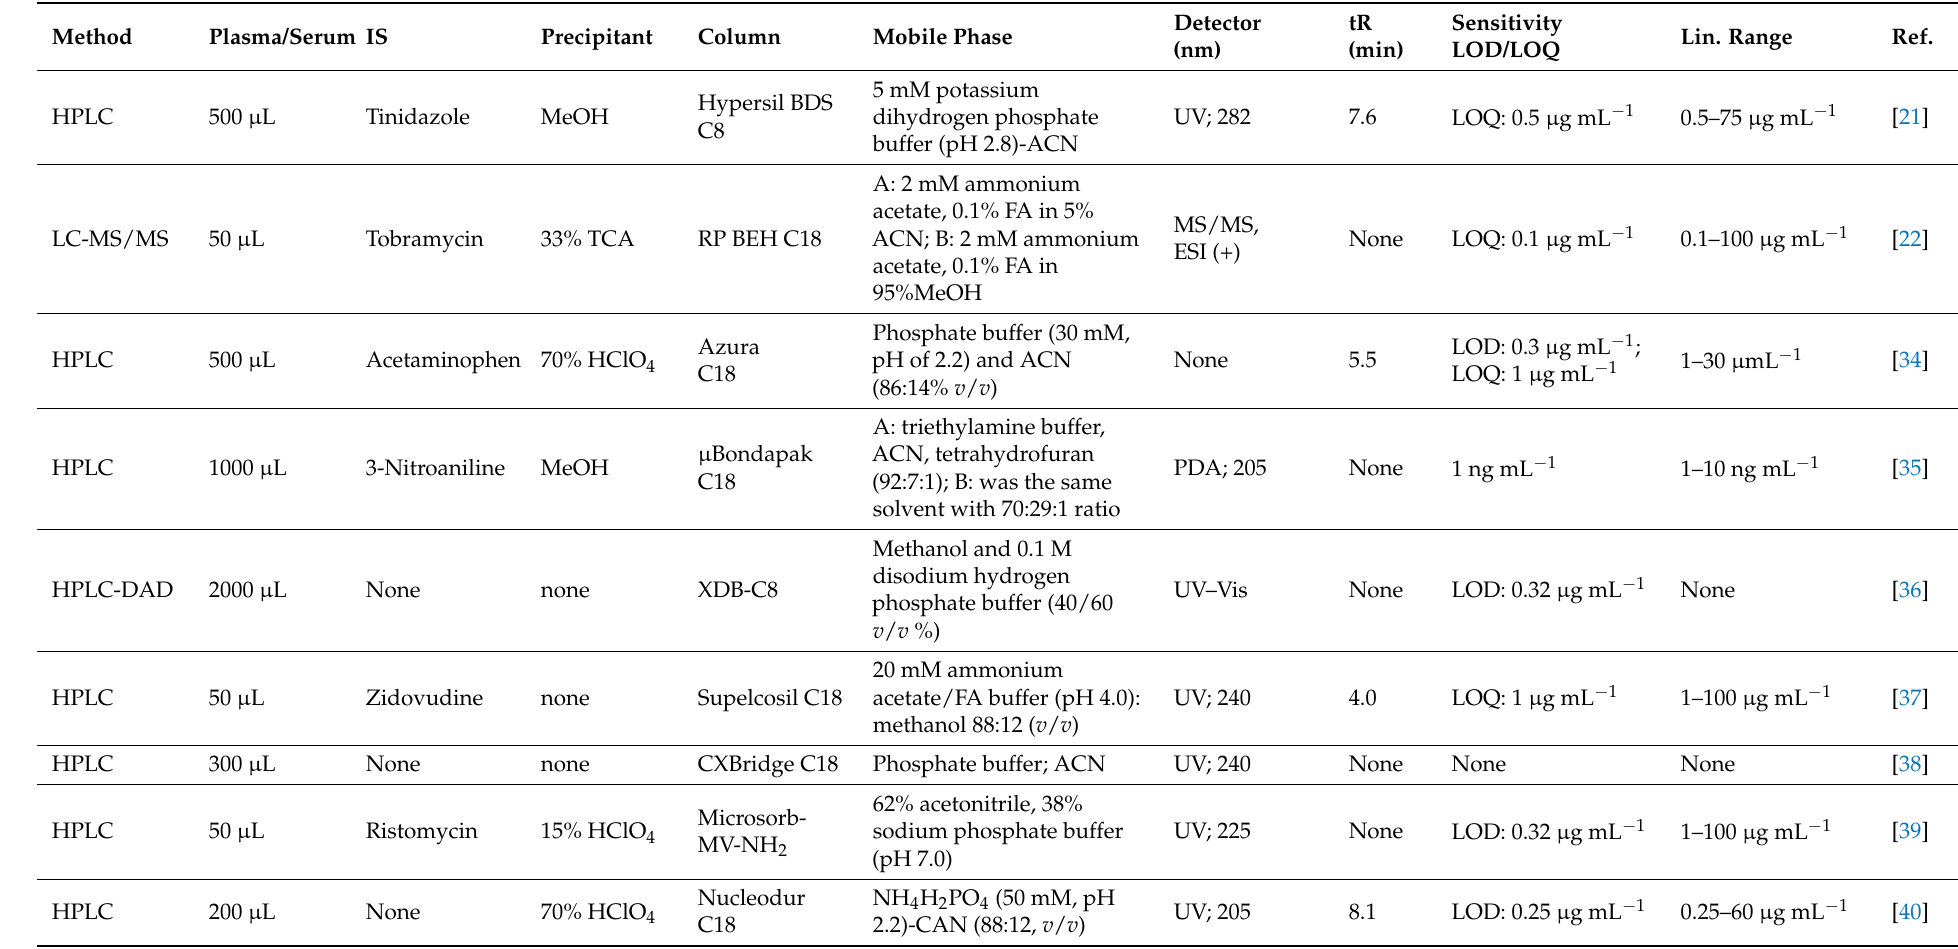
Table 3. Summary of the plasma measurement method and analysis of